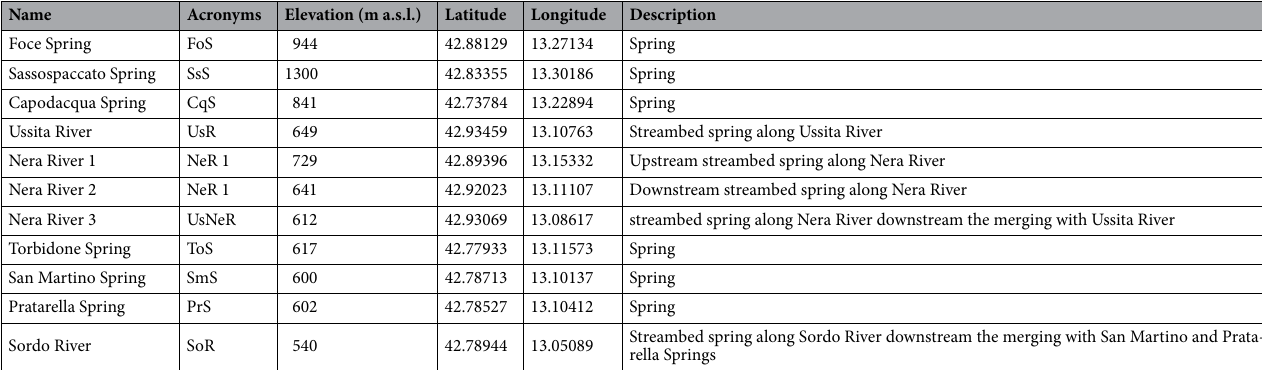
Table 1. List of acronyms used to indicate measuring points, location and brief description of each. Latitude and longitude are given in WGS 84 with an accuracy of about 1